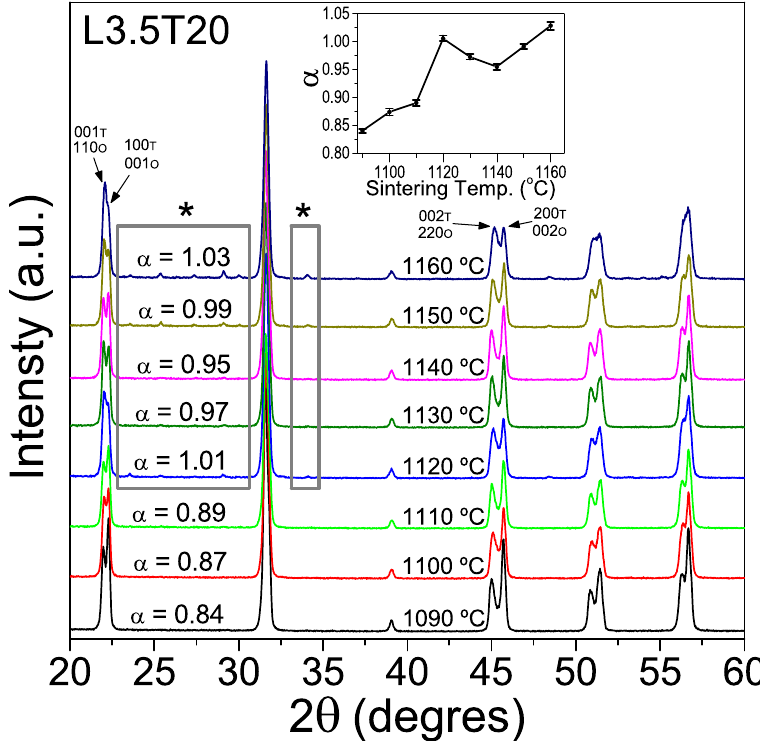
Figure 4. XRD patterns for ceramics with composition L3.5T20, sintered at different temperatures for 2 h. The 001, 100, 002 and 200 peaks of the tetragonal phase were identified with the (T) letter, while the 110, 001, 220 and 002 peaks of the orthorhombic phase were identified in with the (O) letter. Asterisks mark peaks belonging to the secondary phase K 3 Li 2 Nb 5 O 15 . Inset graph shows the evolution of the α parameter with the sintering